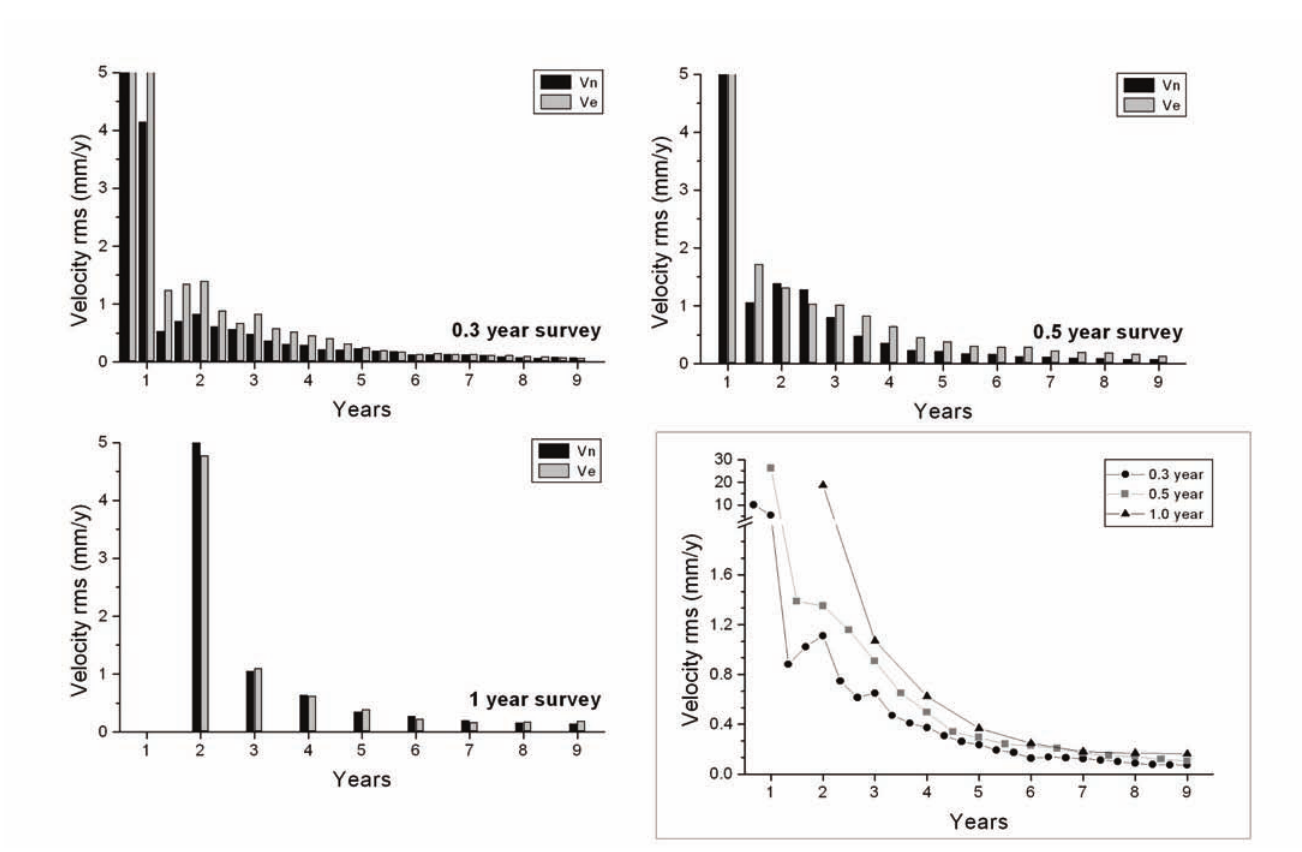
Figure 2. Rms of the velocity differences obtained by simulating 14-day campaigns characterized by different frequencies (campaigns per year). Bottom right panel: summary of the data showing the means of east and north velocity